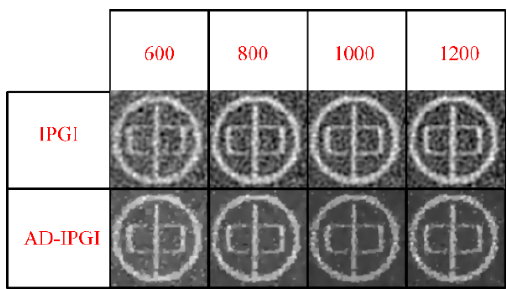
Figure 4. Experimental results for the imaging object “Zhong” obtained by iterative pseudo-inverse ghost imaging (IPGI) and anisotropic diffusion -IPGI (AD-IPGI) with 600, 800, 1000 and 1200 measurements.